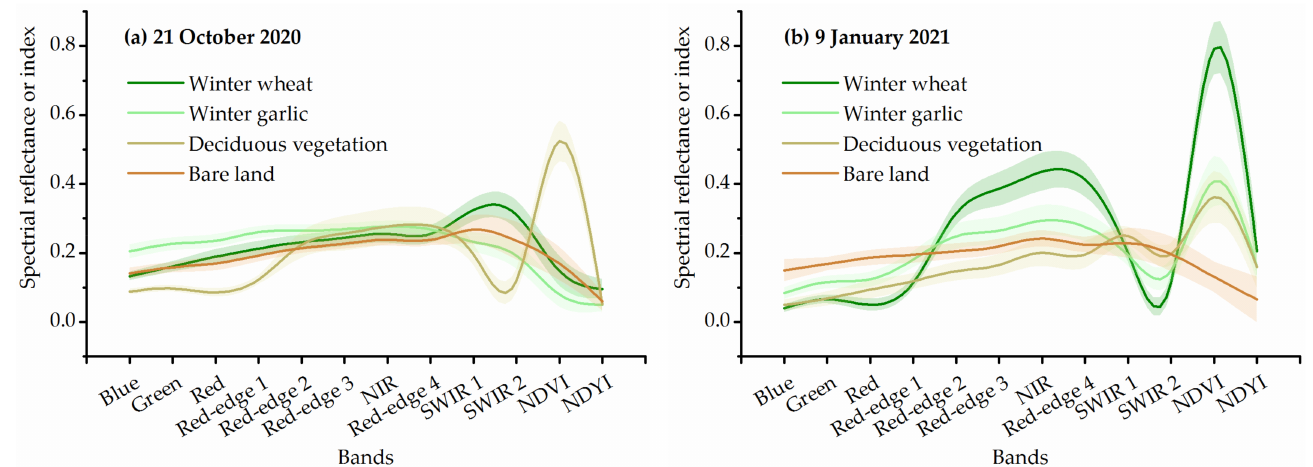
Figure 3. Spectral, NDVI and NDYI profiles derived from Sentinel-2 imagery from ( a ) 21 October 2020 and ( b ) 9 January 2020 in the second study region. Solid lines represent means and shaded areas represent one standard deviation from the